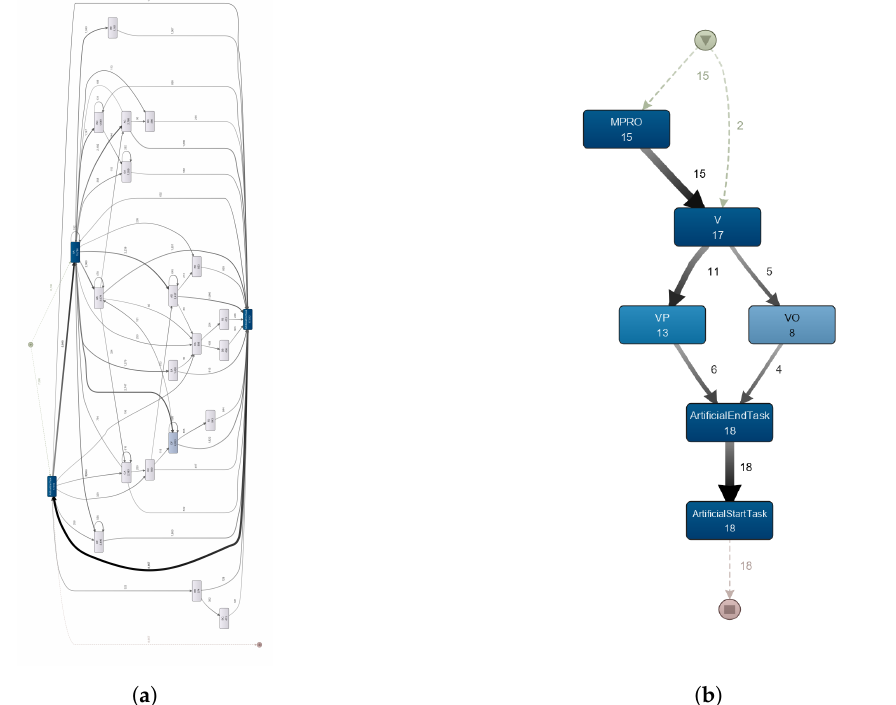
Figure 1. Samples of Spaghetti and Lasagna processes. ( a ) Example of Spaghetti Process; ( b ) Example of Lasagna